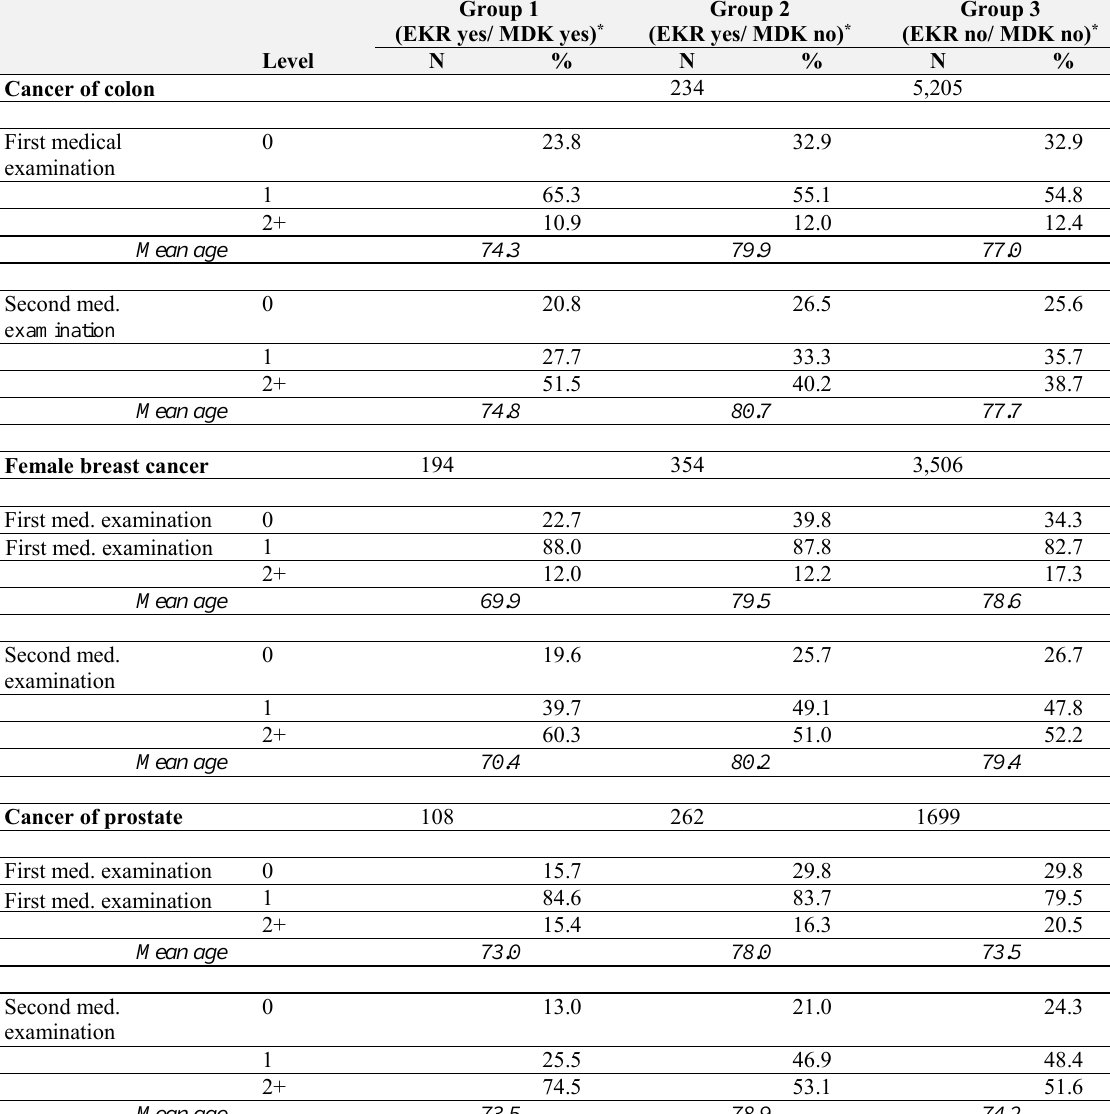
Table 5. Changes from first to second medical examination to establish level of nursing care support among MDK patients, by cancer case status in cancer registry (EKR) and MDK